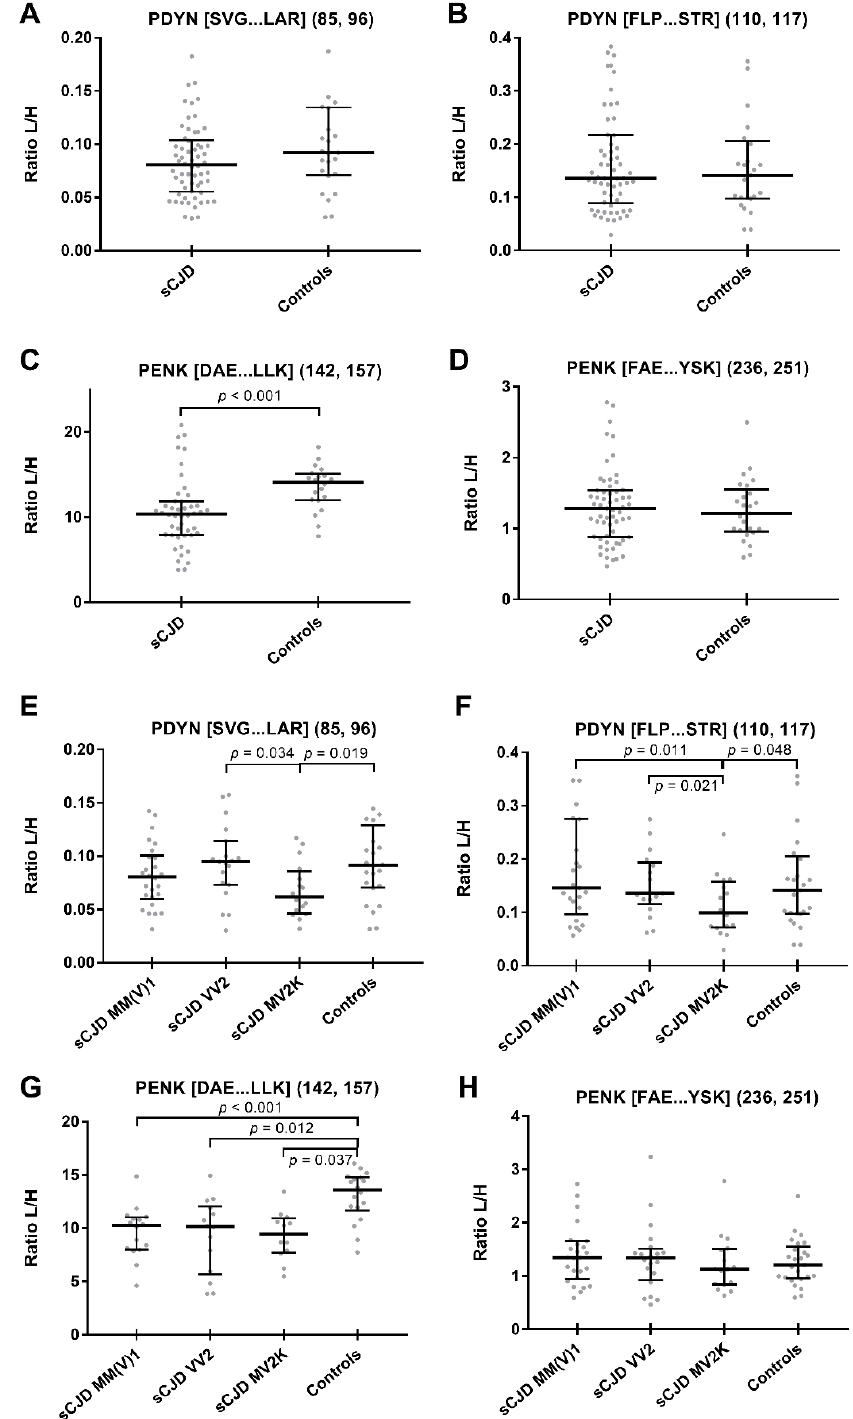
Figure 1. CSF levels of PENK and PDYN in sCJD, its subtypes and controls. Levels were determined by the measurement of two PDYN peptides ([SVG...LAR] and [FLP...STR]) and two PENK peptides ([DAE...LLK] and [FAE...YSK]) by targeted liquid chromatography-tandem mass spectrometry. The median and interquartile range are shown for the ratio of light peptides to spiked heavy labelled peptides (L/H). Kruskal–Wallis test and Dunn’s post hoc test. Comparisons of biomarker levels between sCJD and controls are shown in subfigures ( A – D ), whereas comparisons among sCJD subtypes and controls are shown in subfigures ( E – H ).